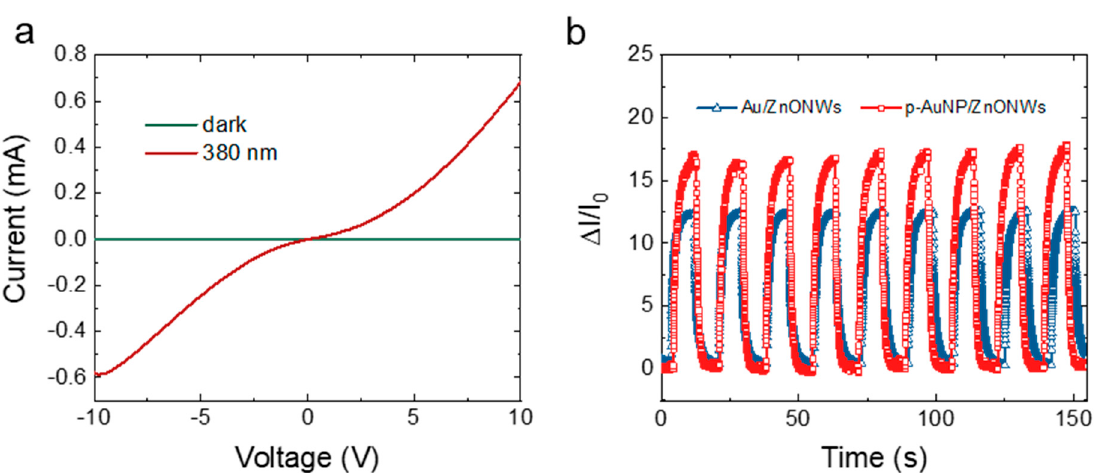
Figure 5. ( a ) I − V curves of the ZnONWs-based photodetector under dark and light, the applied bias voltage was 5 V. ( b ) Relative change in the current curves of the photodetectors.